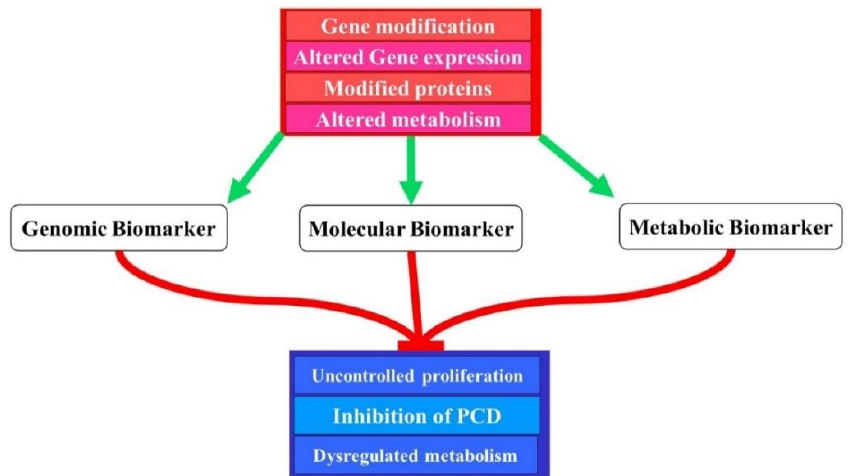
Figure 2. Different biomarkers may be identified as a result of various genetic and proteomic alterations. These alterations may lead to different pathologic conditions such as cancer by breaching proliferation marks, invading programmed cell death mechanisms and altering metabolism.